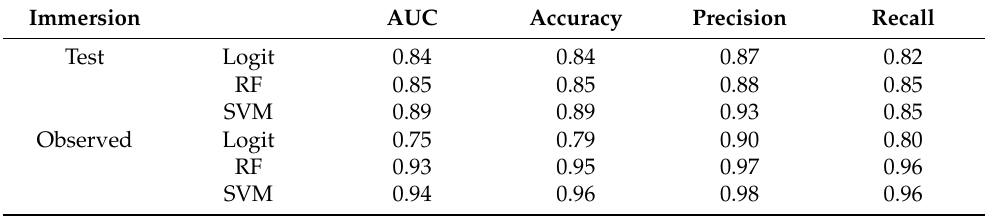
Table A11. ML classification of Energy using Immersion and PS with a 2 day lag in regularized